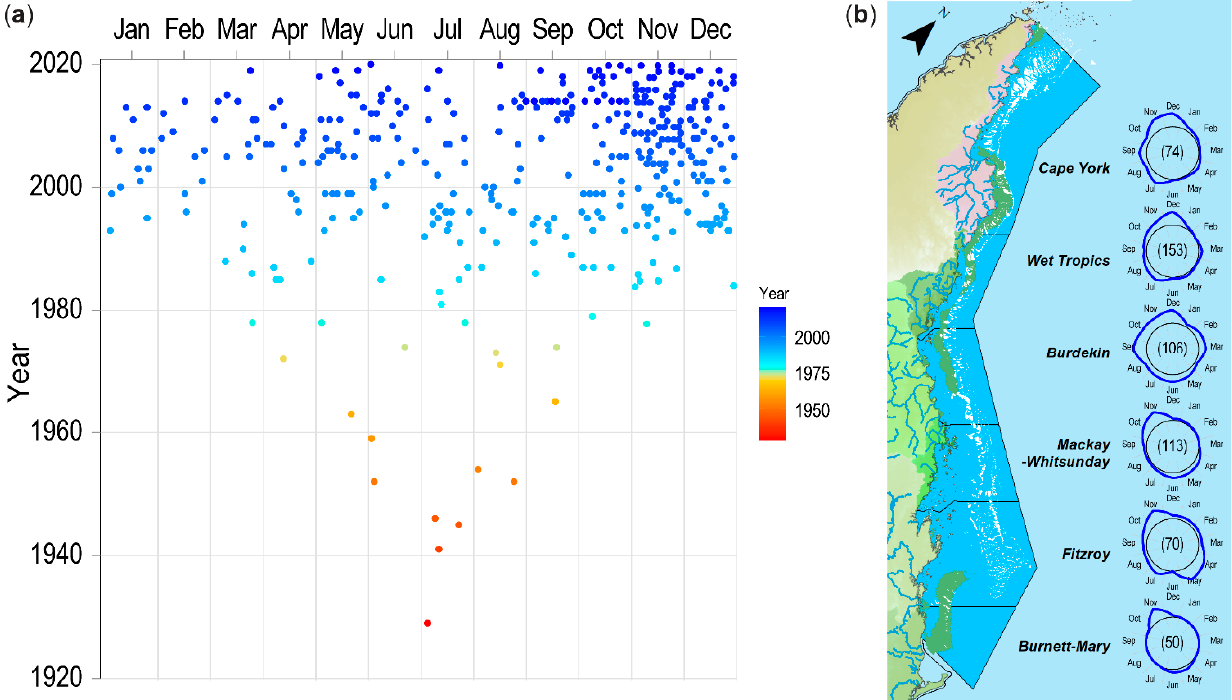
Figure 6. Temporal occurrence in seagrass meadow mapping events within the Great Barrier Reef World Heritage Area: ( a ) within and across years, where each dot represents a mapping event, with the colour gradient representing recent years with colder colour tones, and older years represented by warmer colour tones; ( b ) intra ‐ annual trends within each Natural Resource Management region, where the blue line around each temporal plot represents mapping frequency in monthly intervals (scaled to monthly maximum) over the last century (1920–2020) and the value in the centre of each plot is the total number of mapping events. Source data are provided in Table S1.